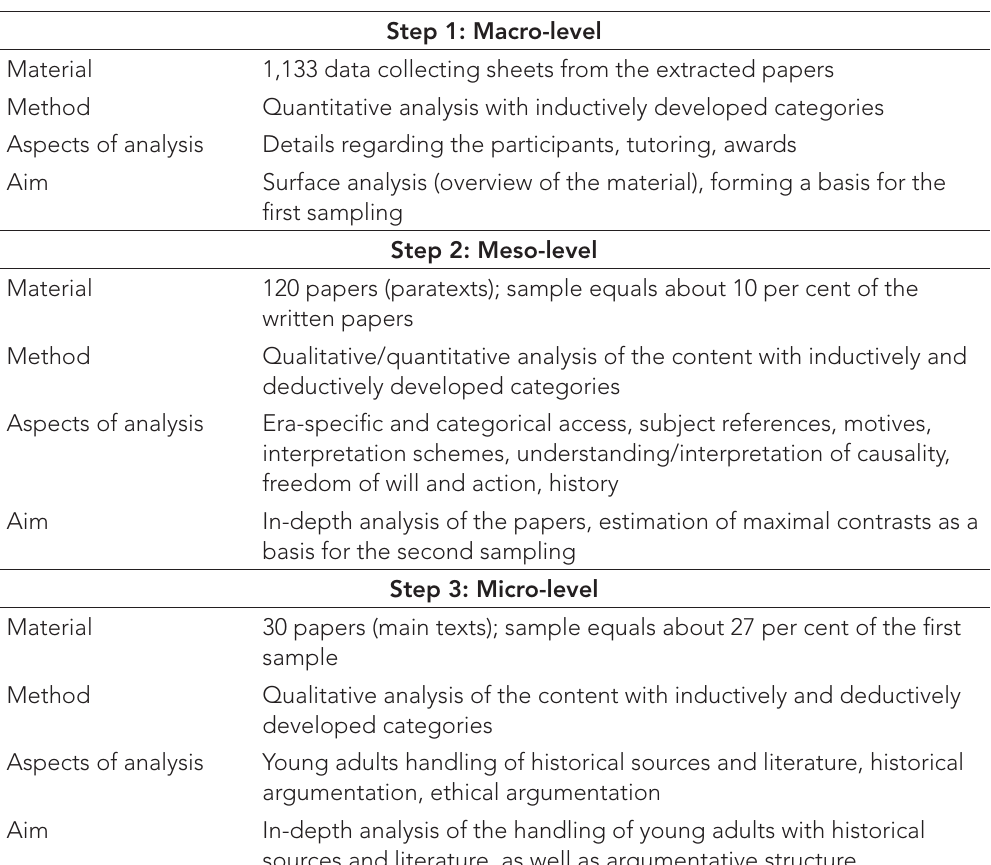
Table 1: Methodological